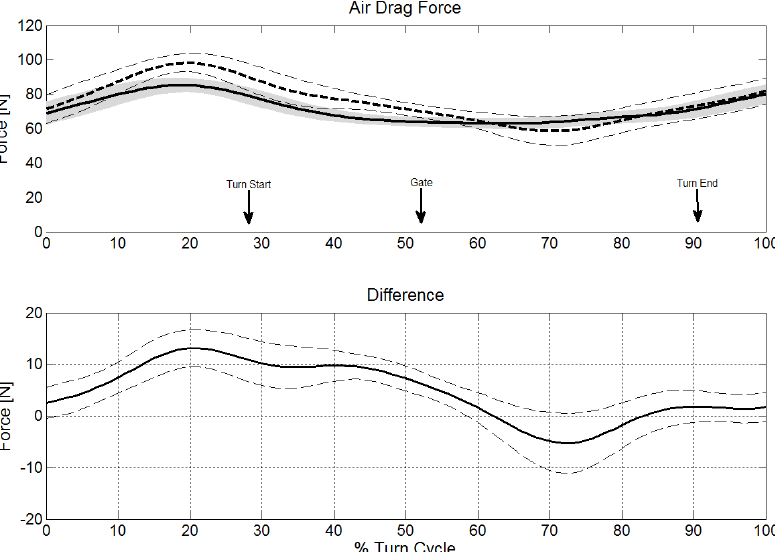
Figure 6. The comparison of the air drag force calculated from the dGNSS method ( F , solid line) and the reference system ( F , thick dashed line) with their D,dGNSS F,REF standard deviations ( F , gray area; F , thin dashed lines) is provided in the upper D,dGNSS D,REF part of the graph. The bottom part of the graph shows the instantaneous average vectorial difference (solid line) and instantaneous AVD-Within-SD (dashed lines) across the turn cycle. Gate passage and the points where the turn radius is less than 30 m are marked as turn start and turn